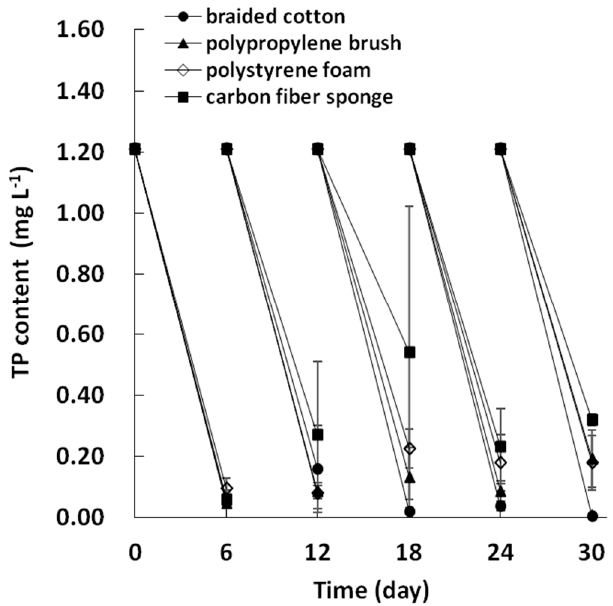
Figure 4. Total phosphorous concentration in the bioremediation test with different biofilm carriers (Error bars represent the standard deviation, N = 2).